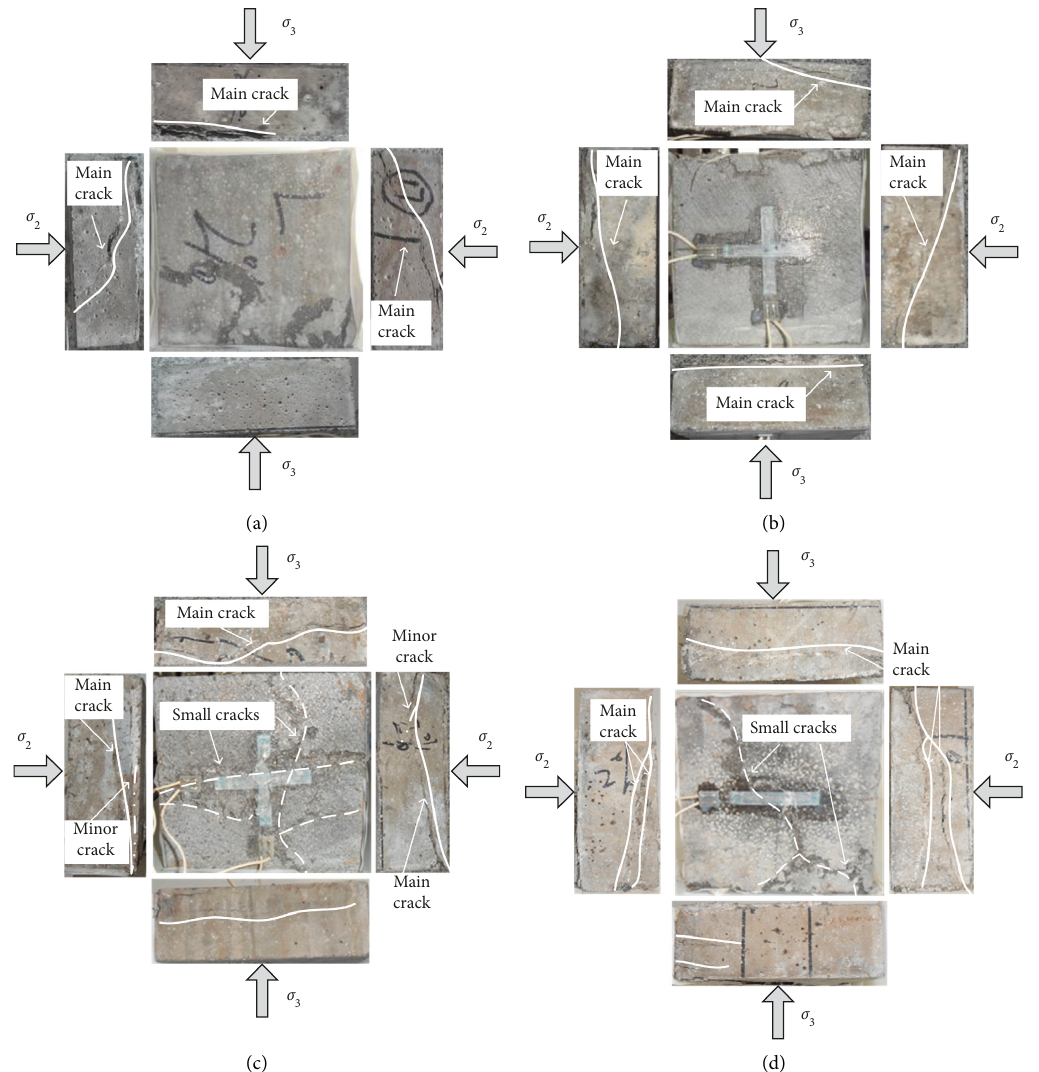
Figure 6: Failure modes of RPC C-C specimens under (a) k � 0.4, (b) k � 0.6, (c) k � 0.8, and (d) k �